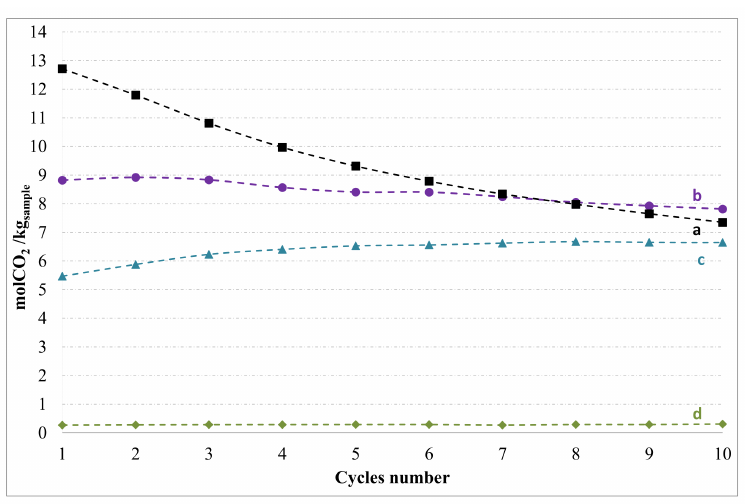
Figure 6. CO 2 sorption/desorption cycles TGA test of (a) C100 (b) C85, (c) C56, and (d) May.